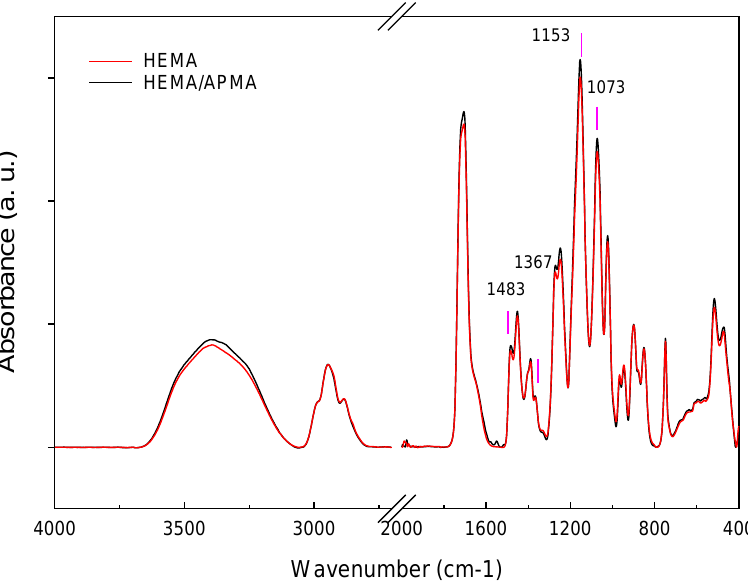
Figure 2. Fourier-transform infrared – attenuated total reflectance (FTIR – ATR) spectra recorded for HEMA and HEMA/APMA contact lenses.